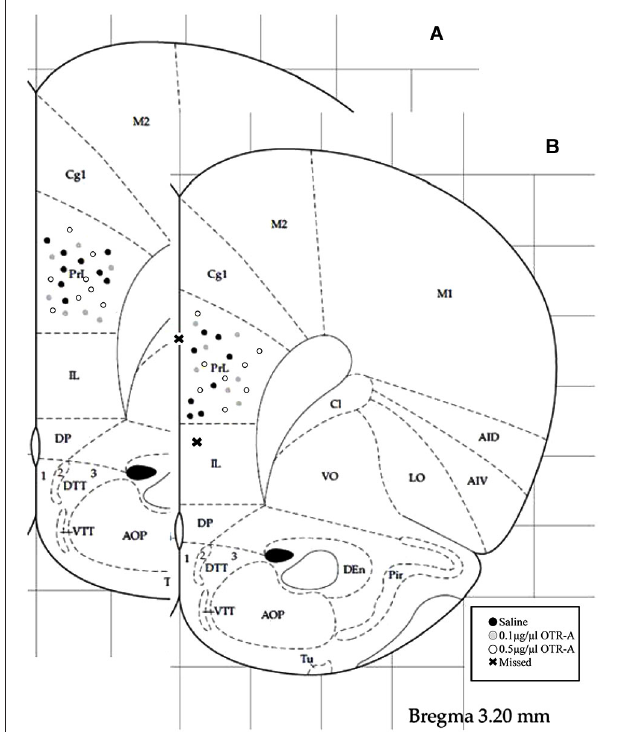
FIGURE 1 | Schematic representation of mPFC cannula placements . Cannula tip placements were in the prelimbic region (PL) of the mPFC (AP: +3.2 mm, ML: ± 0.5 mm, DV: − 3.2 mm). Each dot indicates an individual subject. Infusions were bilateral but are represented unilaterally.